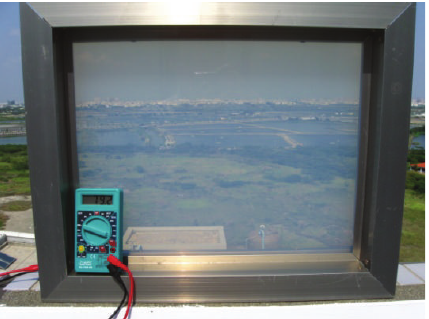
Figure 3: The implemented cross-sectional dimension (in propor- tion) for a typical diffusive solar cell